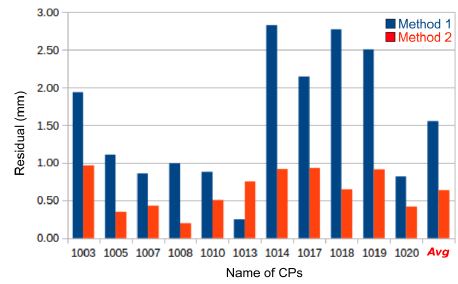
Figure 13. Accuracy check on CPs - Case 1